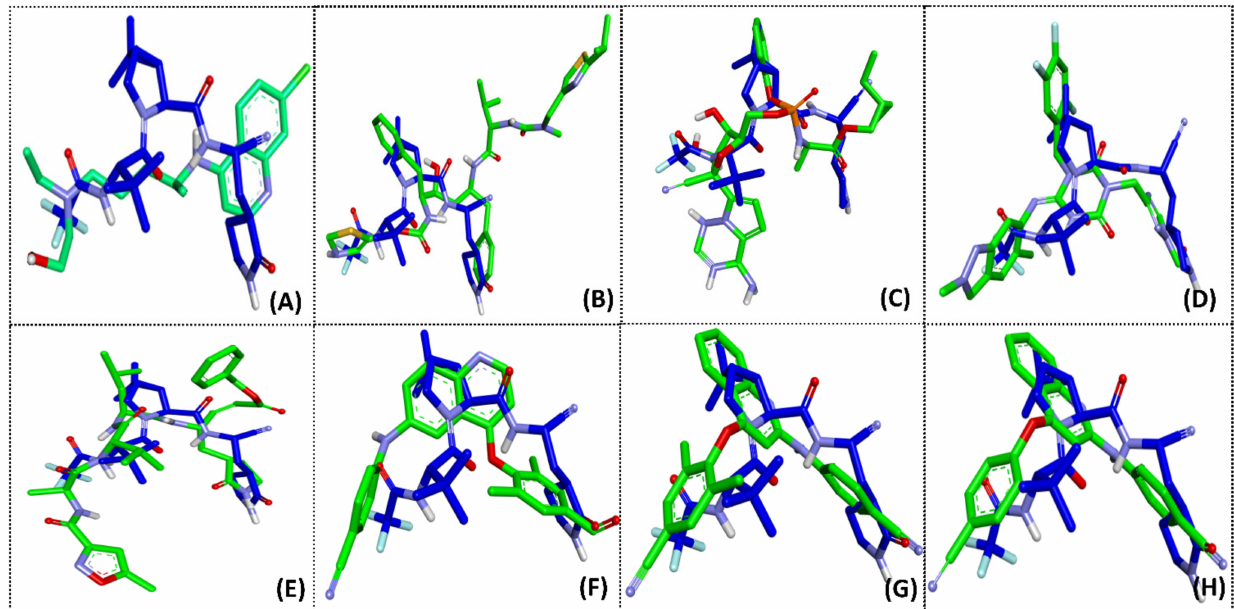
Figure 3. Overlay of the conformations of the analyzed ligands (green): hydroxychloroquine ( A ), ritonavir ( B ), remdesivir ( C ), S-217622 ( D ), N3 ( E ), ( 1 ) ( F ), ( 6 ) ( G ), and ( 8 ) ( H ) with PF-07321332 (blue) in the binding pocket of M pro